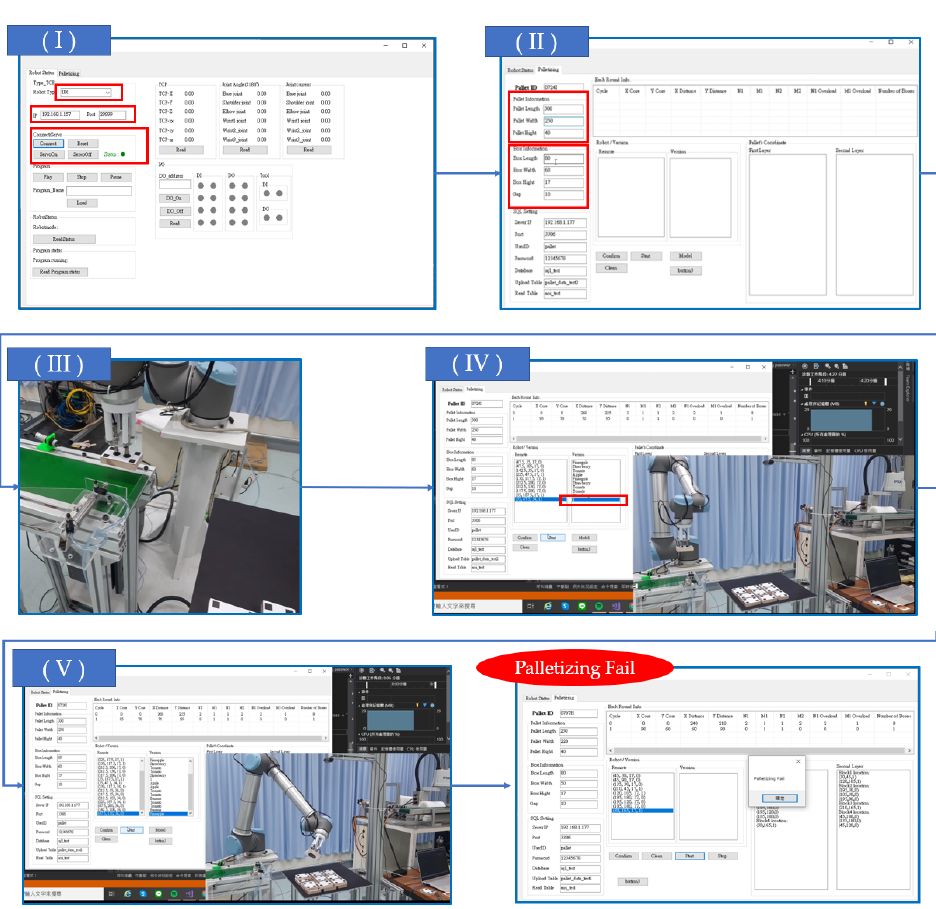
Figure 37. Practical arrangement action. ( I ) Robot status. ( II ) Palletizing parameters. ( III ) Pick-up motion. ( IV ) Single-layer palletizing complete. ( V ) Palletizing check.